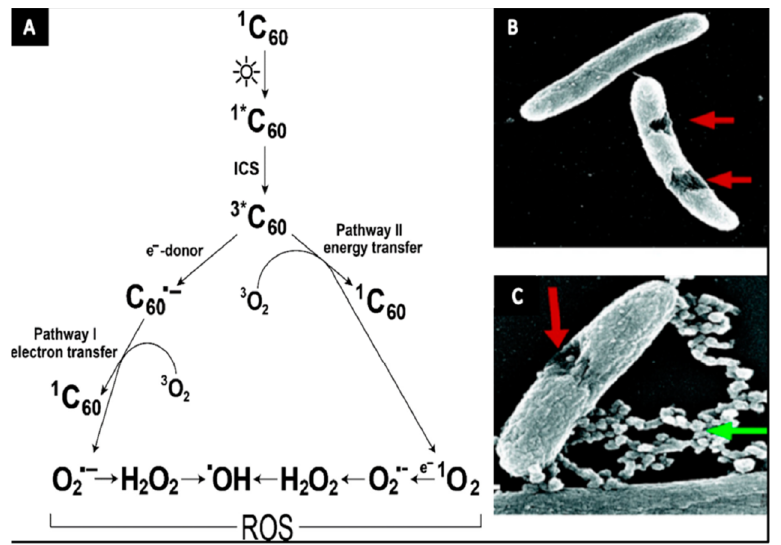
Figure 15. Fullerene C60 photochemical pathways leading to reactive oxygen species, ROS, genera- tion ( A ), Damaged S. oneidensis MR − 1 cells treated with C60 − NH2 ( B , C ) [128]. ( A ), Damaged S. oneidensis MR − 1 cells treated with C60 − NH2 ( B , C )